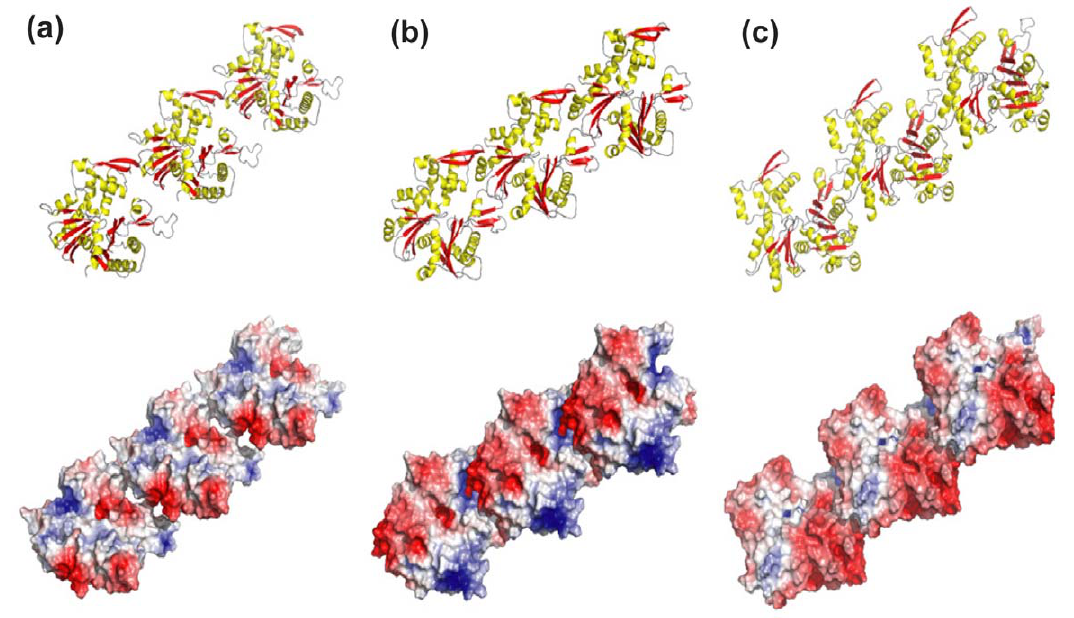
Figure 8. 3-dimensional filament modeled structures of the fiber-like structures of MamK, MreB and actin-F. 3-dimensional modeled structures of the fiber-like structures of MamK (A), MreB (B) and actin-F (C) as they would form filaments are shown in the upper panel and the corresponding global electrostatic surface potentials of each protein contoured at 5 kT are shown in the lower panel. The active site of MreB is indicated by the arrow and is likely to reside in a similar position in MamK and actin. Red represents regions of negative electrostatics, blue represents regions of positive electrostatics, while white is neutral. This analysis was carried out using Adaptive Poisson-Boltzmann Solver (APBS) through solution of the Poisson-Boltzmann equation (PBE) using default parameters with contour values ranging from 2 5 to 5.